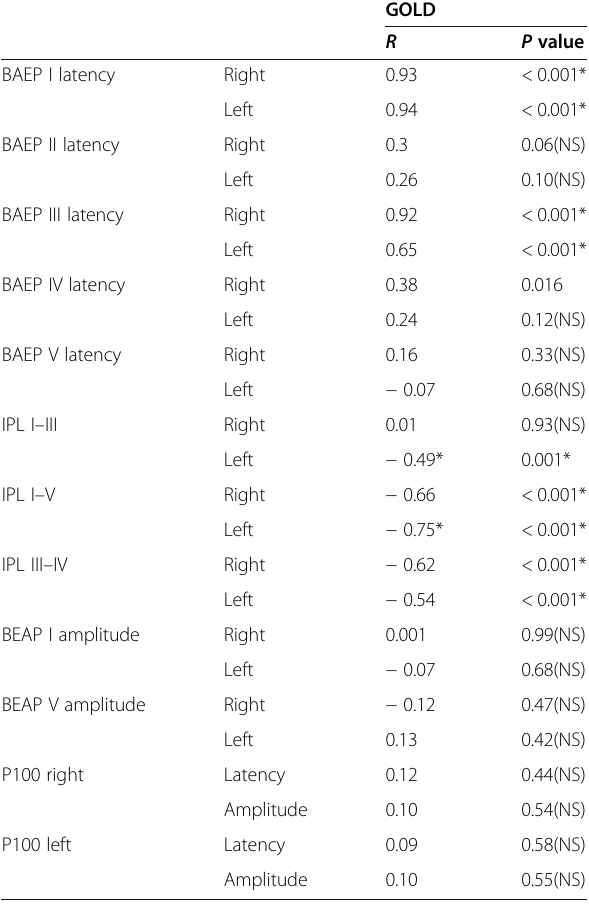
Table 5 Comparison between patient and control groups as regards the number of cases with affected brainstem auditory evoked potentials